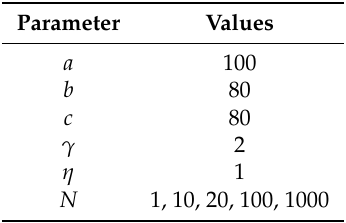
Table 12. Simulation